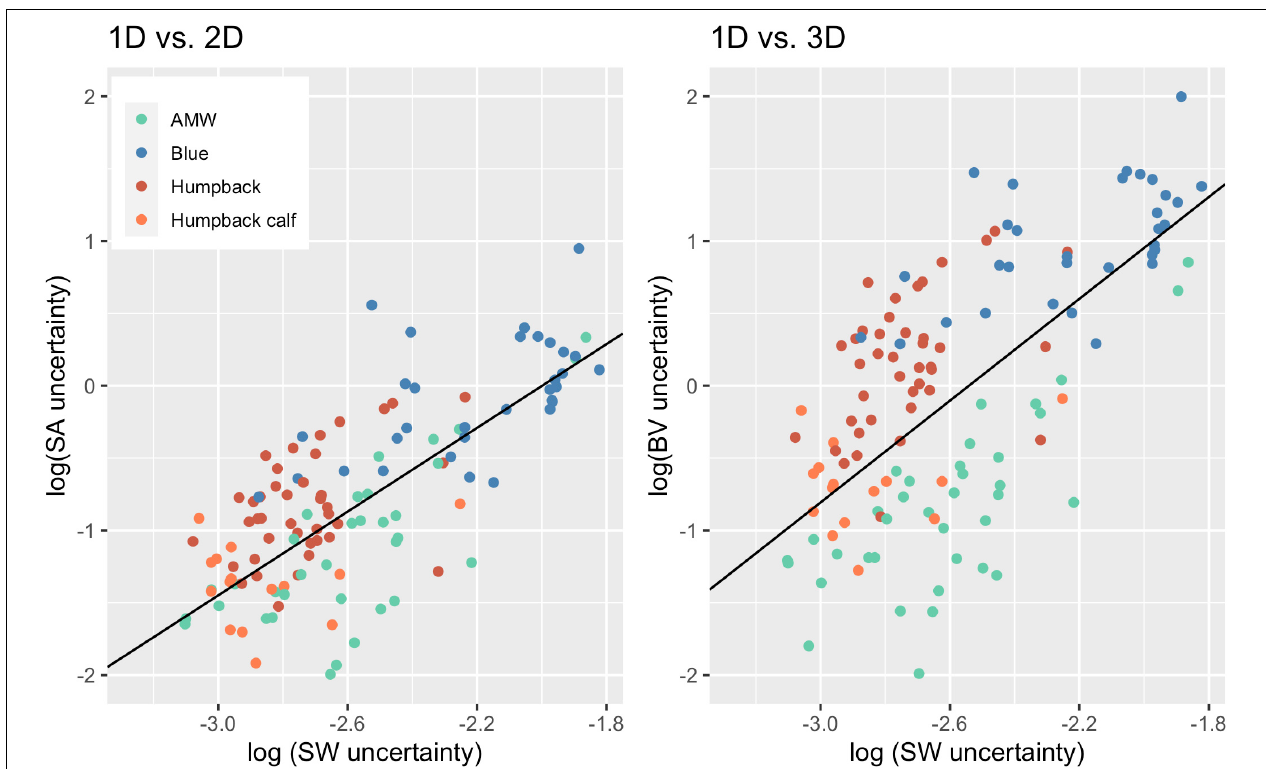
FIGURE 5 | Scaling of 2D and 3D uncertainty with 1D uncertainty. Each point represents an individual whale and the uncertainty (defined here as the SD of the posterior predictive distribution for each metric), associated with 1D, 2D, and 3D body condition metrics. The black lines represent the linear regression for uncertainty between 1D and 2D (slope = 1.45; CI: 1.20, 1.69; intercept = 2.89) and 1D and 3D (slope = 1.76; CI: 1.39, 2.13, intercept = 4.47). Data from 40 Antarctic minke whales (AMW), 32 blue whales, 40 humpback whales, and 15 humpback whale